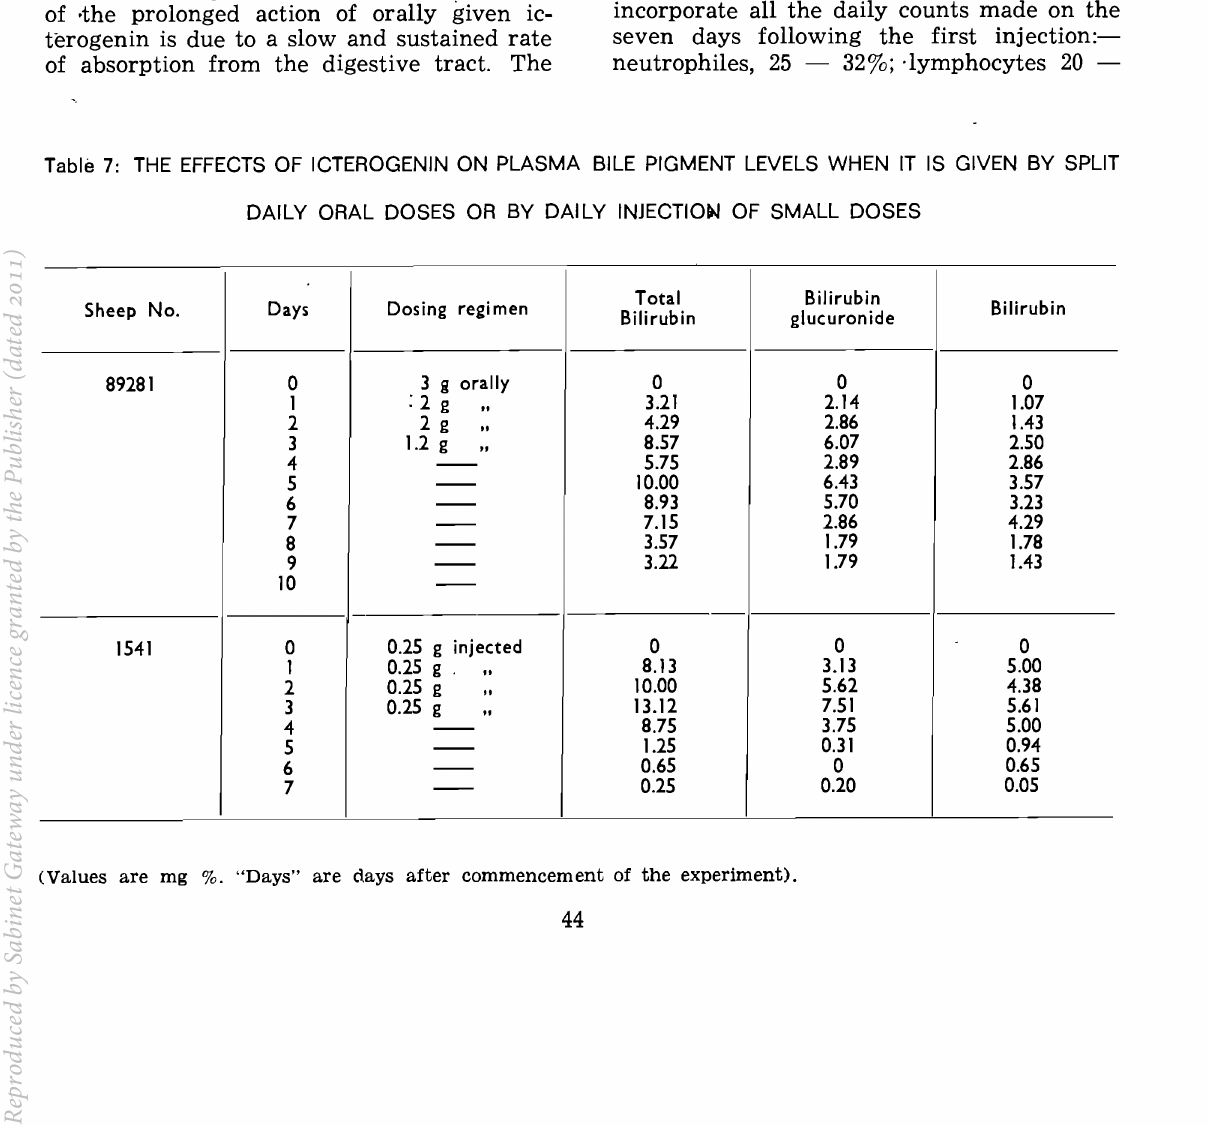
of absorption from the digestive tract. The